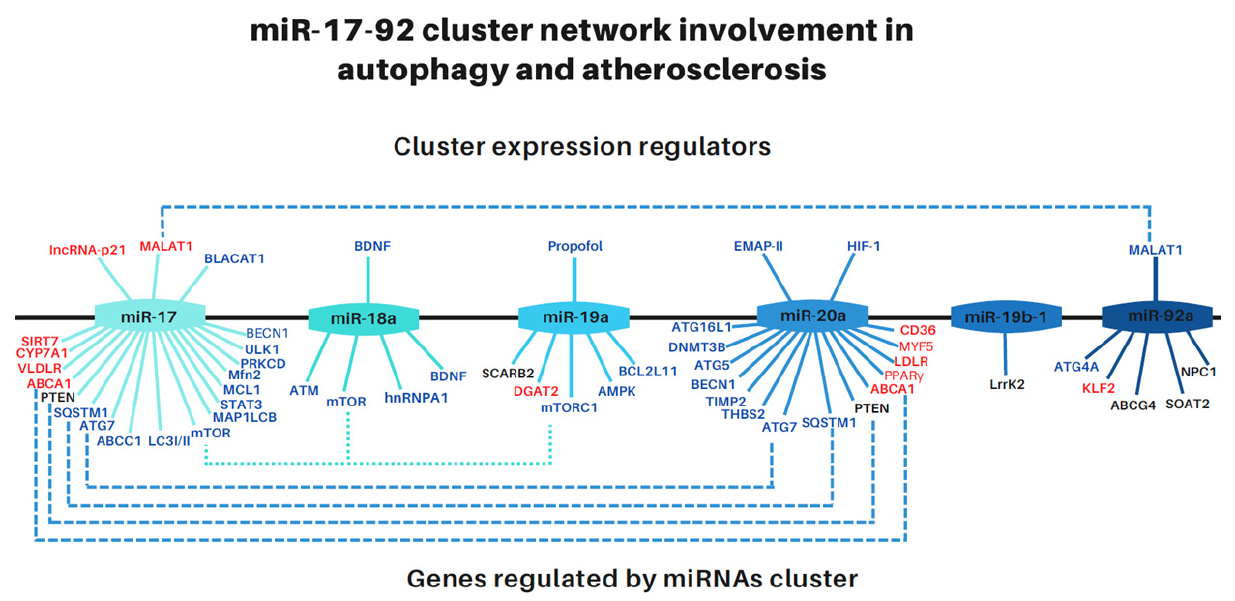
Figure 1. Regulatory network of the miR-17-92 cluster involved in autophagy and atherosclerosis . The cluster is composed of six miRNAs. The upper part of the line shows which molecules could regulate the expression of each miRNA. At the bottom of the line, the gene targets for each miRNA are illustrated. Those that match are linked by lines. Genes in bold are those verified experimentally and non-bold are hypothetical targets with a binding sequence for the miRNA. In red are genes involved in atherosclerosis, in black are genes involved in autophagy, and in blue are those involved in lysosomal storage diseases. Abbreviations: cancer-associated transcript 1 (BLACAT1), metastasis-associated lung adenocarcinoma transcript 1 ( MALAT1 ), cytochrome P450 family 7 subfamily A member